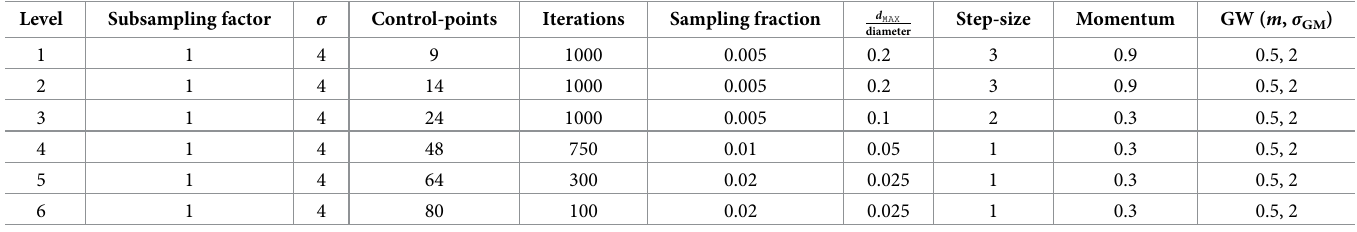
Table 3. INSPIRE parameter configuration for subject-to-subject registration of 3D MR images of brains. For all levels: λ = 0.01, N α = 7, normalization percentile q = 0.1%, histogram equalization (using 256 bins) is enabled, β = 1.2 and d t = 20. Level Subsampling